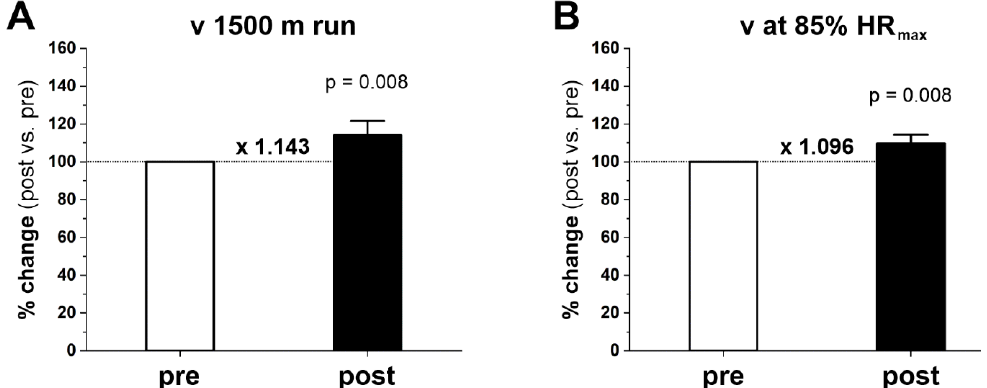
Figure 1. Effect of 20 weeks of endurance training on running performance over a distance of 1500 m. Mean running speed during the race ( v 1500 m) ( A ) and the level of running speed reached at 85% maximal heart rate ( v at 85% HR max ) ( B ). Results are expressed as the percentage change after training (post) in relation to the status before training (pre), which is presented in the graph as 100%. Data are presented as the mean ± standard deviation (SD). The nonparametric Wilcoxon sign rank test with two-sided p-value is shown. Post- vs. prefold changes defined as the ratio of post-training value to pretraining value are marked as a multiple of the change, e.g., ×1.143 is a 1.143-fold increase.